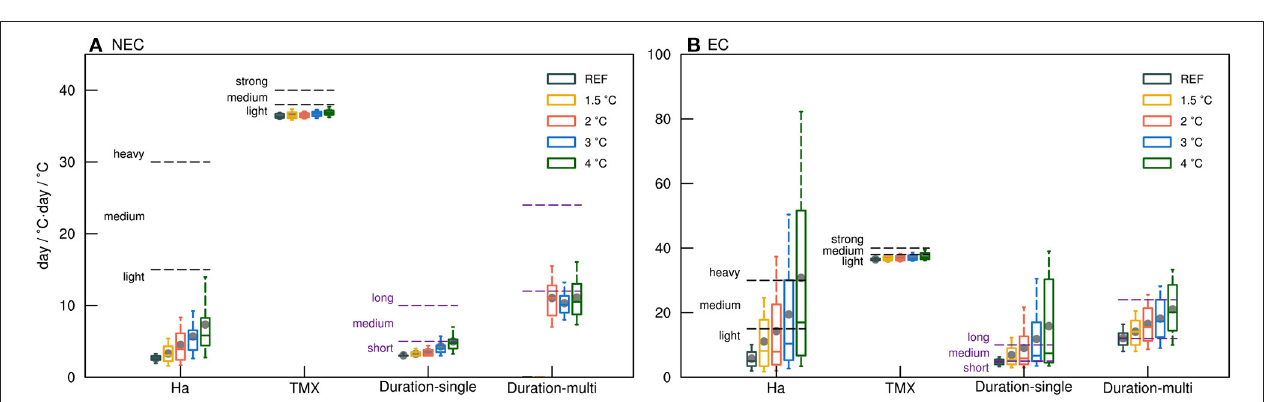
FIGURE 8 | Boxplots of the number of high-temperature days (unit: day), hazardous heat accumulation temperature (unit: ◦ C · day), maximum temperature in the process of heat damage (unit: ◦ C), durations of single- and multiple-process of heat damage (unit: day) of control (1986–2005), and projected climate (2006–2100) by LMDZ-MME averaged over the (A) Northeast China and (B) Central and East China. For future climate projection, warming levels of 1.5, 2, 3, and 4 ◦ C under emission pathway of RCP8.5 are considered. The top and bottom whiskers are the 10th and 90th percentiles. The black and purple dotted lines indicate the corresponding rank of each